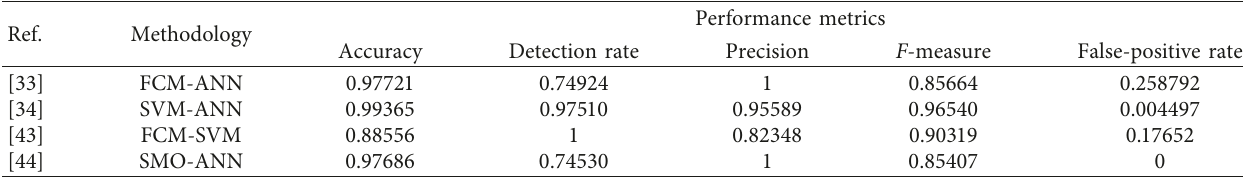
Table 15: Comparison of various methodologies based on different performance metrics for probe attack.